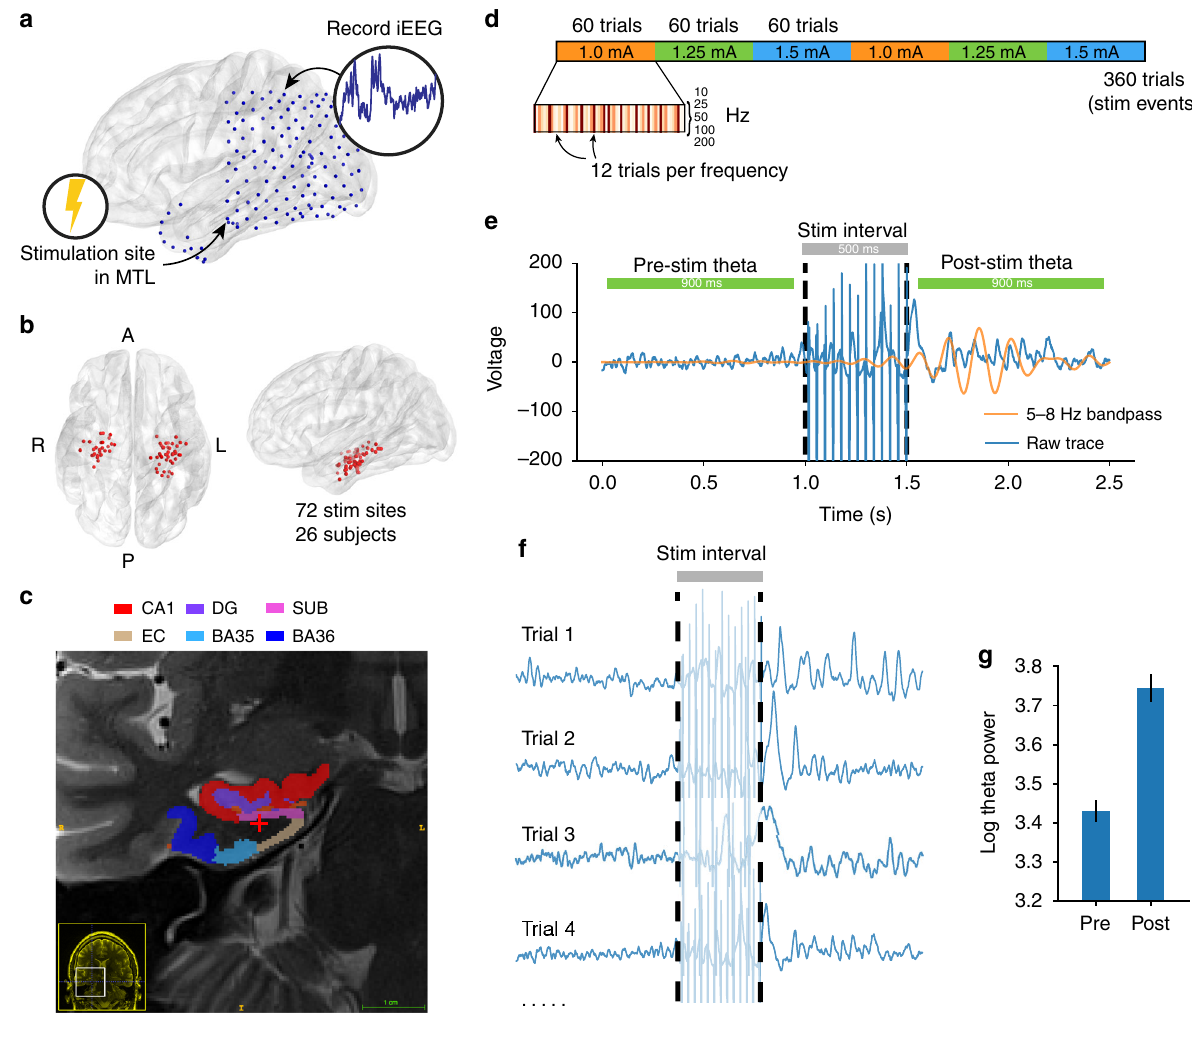
Fig. 1 Comparison of pre- vs. post-stimulation theta (5 – 8 Hz) power in an example subject. a Each of 26 subjects received a series of 500 ms bipolar stimulation events, at 1 – 7 sites within the MTL; an example subject schematic is shown here. b Anatomical distribution of all MTL stimulation sites in the 26-subject dataset. c T2 MRI and MTL subregion segmentation for an example subject. Stimulation location, in white matter, is indicated at the red cross. See Supplementary Figure 1 for subregion labels. d Schematic of a typical stimulation session. Each stimulation site receives stimulation at three amplitudes